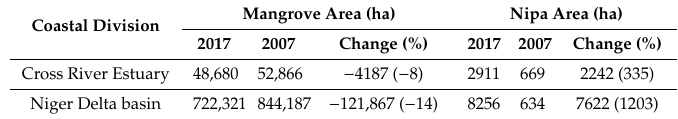
Table 8. Mangrove and Nipa Palm Extent across Coastal Divisions of Coastal Nigeria.